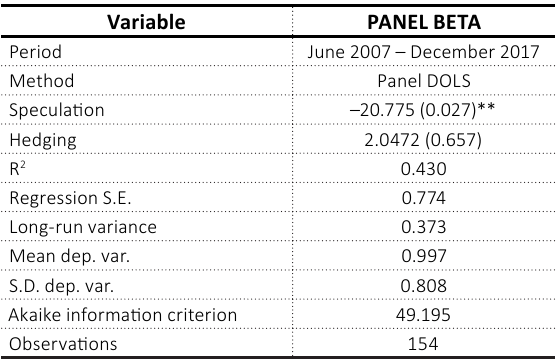
Table 9. The results of the Panel DOLS test